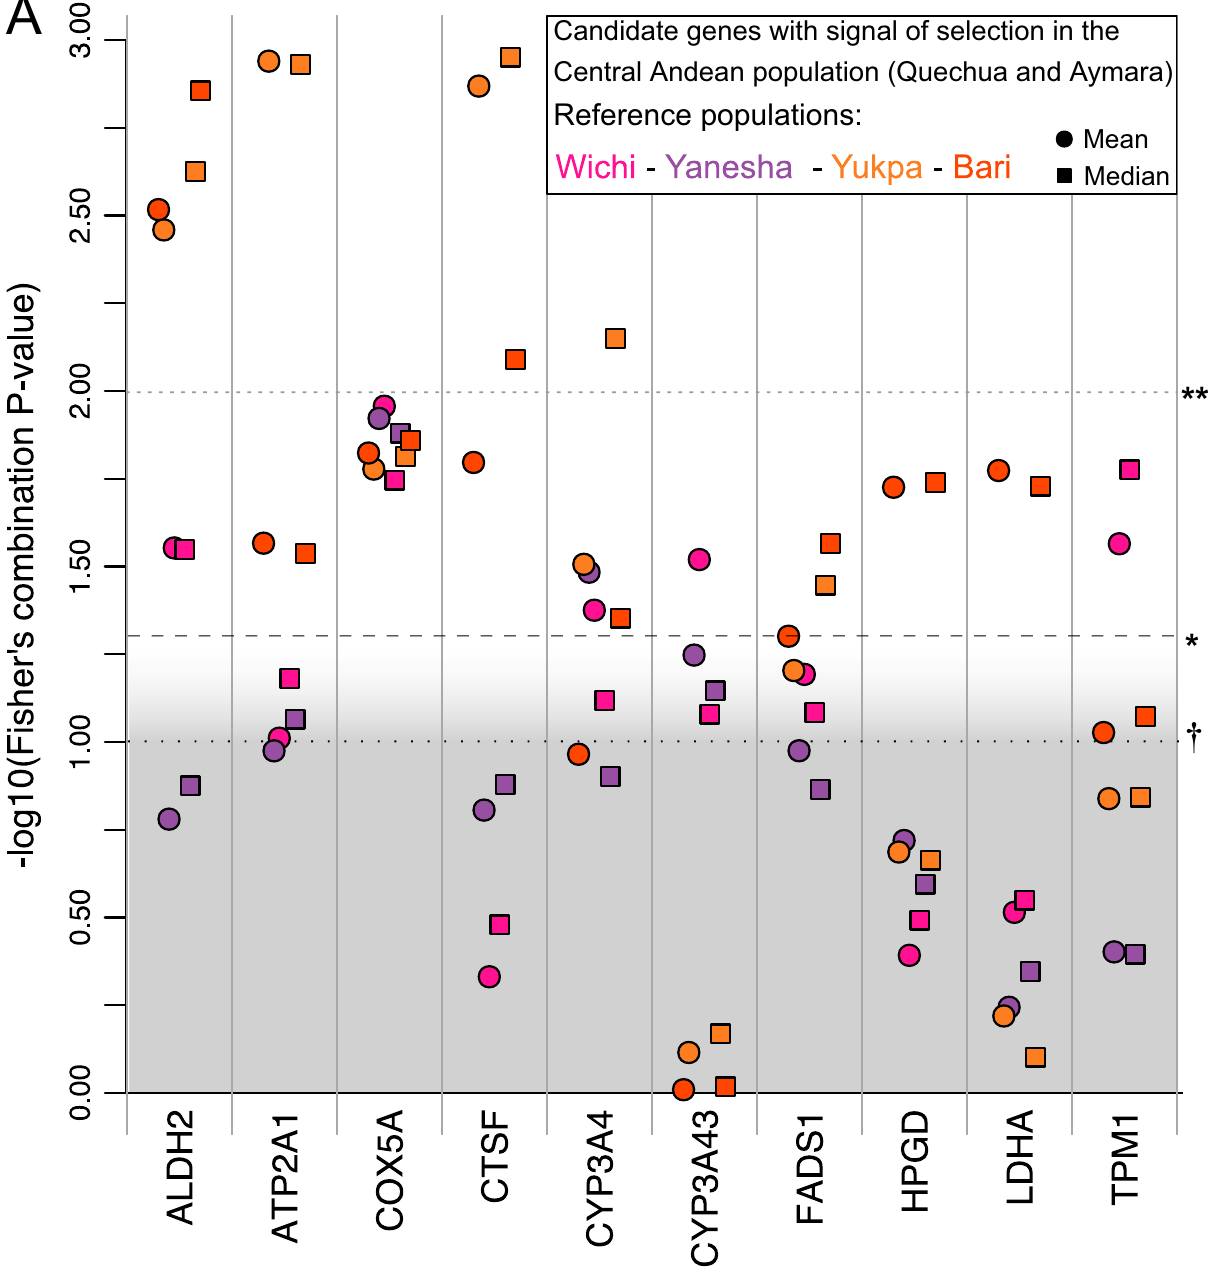
Figure 4. ( A ) Candidate genes exhibiting evidence of positive selection in the Central Andean population. Only candidate genes with at least one significant comparison (i.e., P -value associated to Z F gene-level positive selection score < 0.05) are shown. Squares and circles denote comparisons when median and mean are used as gene-level summary statistics to estimate Z F , respectively. ( B ) Enrichment of signals of selection in the Central Andean population for the set of candidate genes . Left and right halves of violin plots represent the expected distribution of the proportion of background genes exhibiting signals of selection across the genome (estimated from 1,000 control gene sets) when mean and median values were used as summary statistics to estimate Z F , respectively. The proportion of selective signals in our set of candidate genes is represented by squares and circles when median and mean are used as gene-level summary statistics to estimate Z F , respectively. We considered as a signal of selection for a gene when the P -value associated to its Z F score is < 0.05, when using each reference population separately (colored violin plots) or when at least one, two or three P -values associated to Z F scores (using different reference populations) are < 0.05 (gray violin plots) . The significance of the enrichment analysis (i.e., higher proportion of signals of positive selection in the candidate gene set respect to the control gene sets) is shown at the top: † P < 0.1; * P < 0.05; ** P <